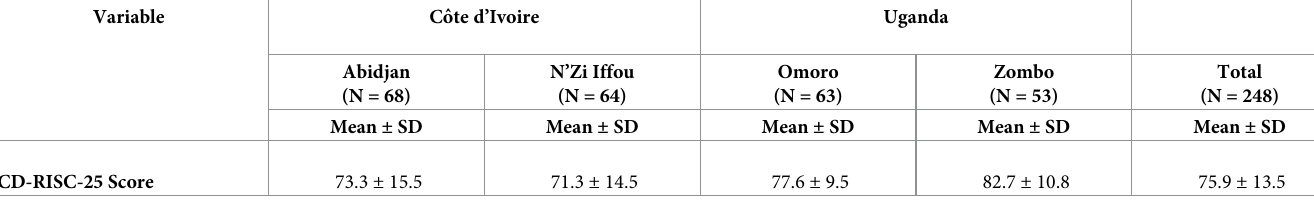
Table 9. Summary of CDDs’ mean CD-RISC-25 scores ± SD, by region/district.